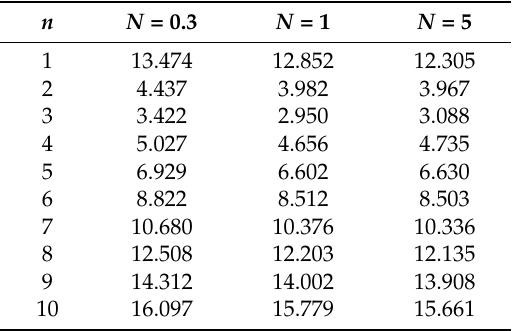
Table 10. Variation of the natural frequency ω (GHz) against circumferential wave number n for different power-law indexes N of FGPM-I